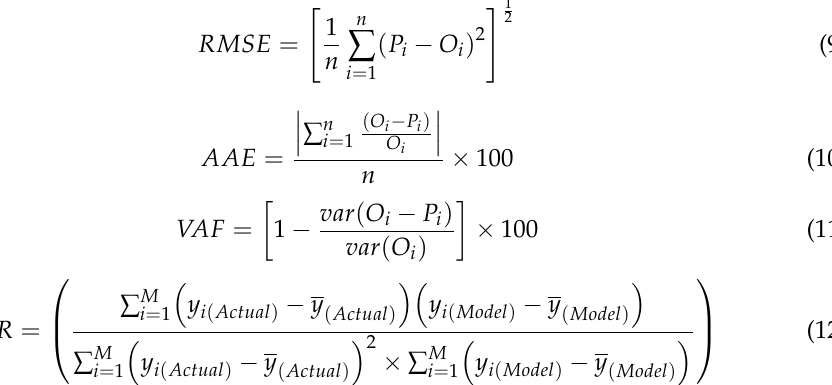
Table 14. Parameters of the GWO algorithm. Parameter